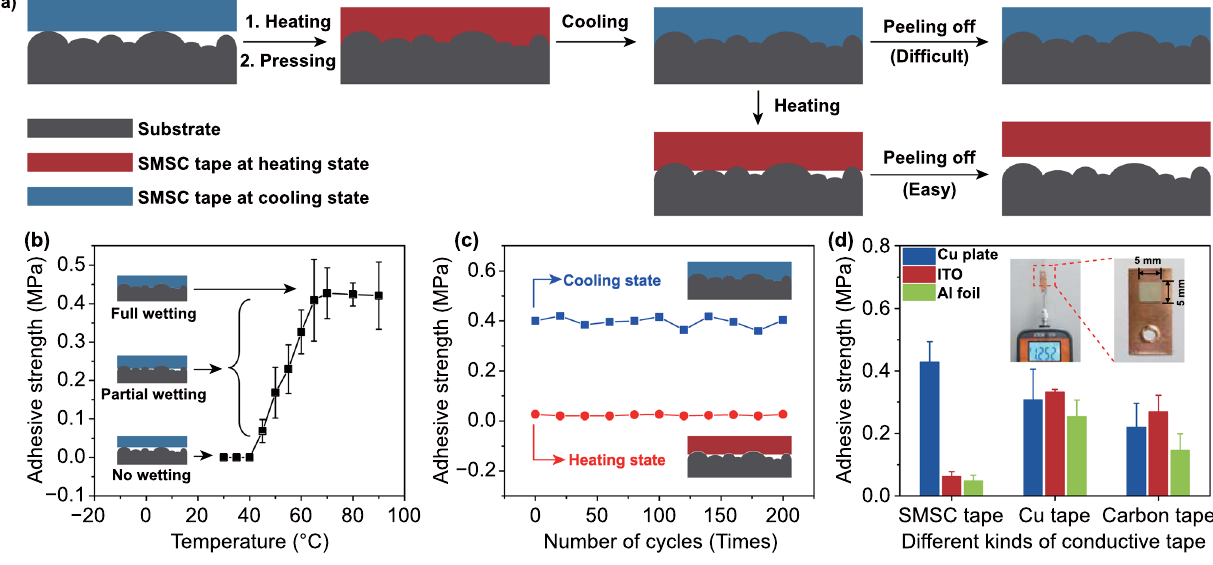
Fig. 4 Reversible adhesion of SMSC tape switched by temperature. a Schematic illustration of adhesion reversible process of SMSC tape switched by temperature. b Shear adhesive strength between SMSC tape and Cu plate at room temperature switched by different heating tem- perature. Inset is the wetting state of SMSC tape at cooling state on rough substrate with the different heating temperature. c Reversible shear adhesive strength of SMSC tape between heating state and cooling state as a function of the number of cycles. The switching temperature is 70 ℃ . d Shear adhesive strength of SMSC tape and two kinds of commercial conductive tape on various conductive surfaces. The inset is a digital image illustrating the adhesion force of SMSC tape on the Cu